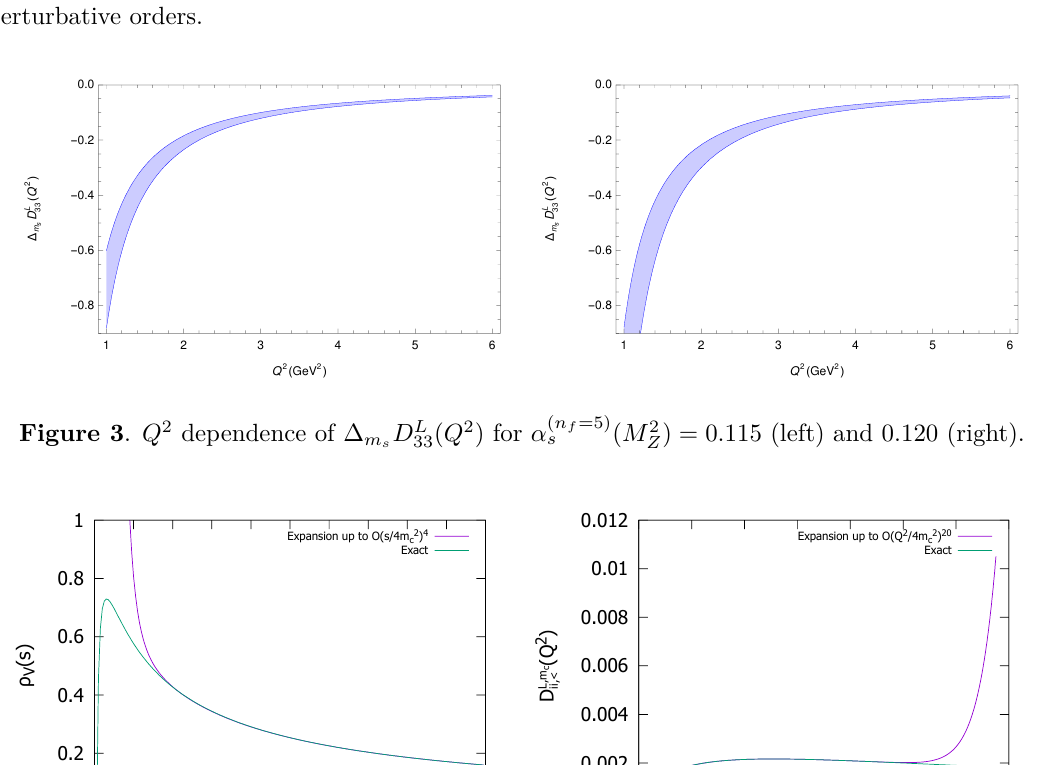
Figure 4 . Left: comparison between the exact form of ρ V ( s ) and its expansion in the limit 4 m 2 /s → ∞ . As can be checked, they are equal for 4 m 2 c D L,m c ( Q 2 ) computed numerically and computed analytically, using the expansion (3.11) for ρ V ( s ) , ii,< and performing an expansion in Q 2 / 4 m 2 been